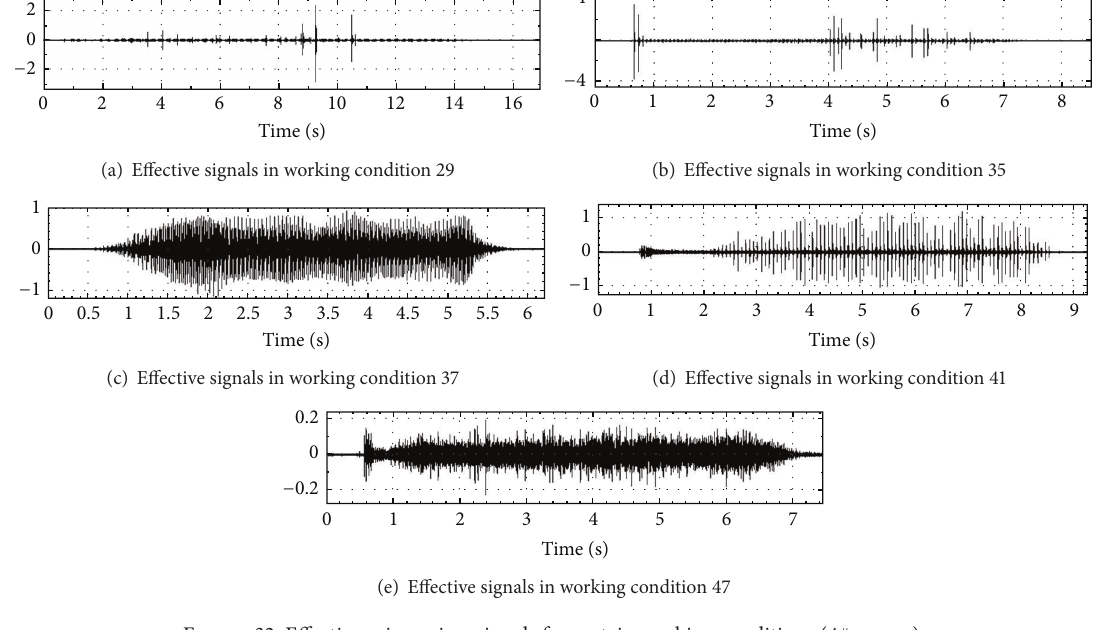
Figure 32: Effective microseism signals for certain working conditions (4# sensor).